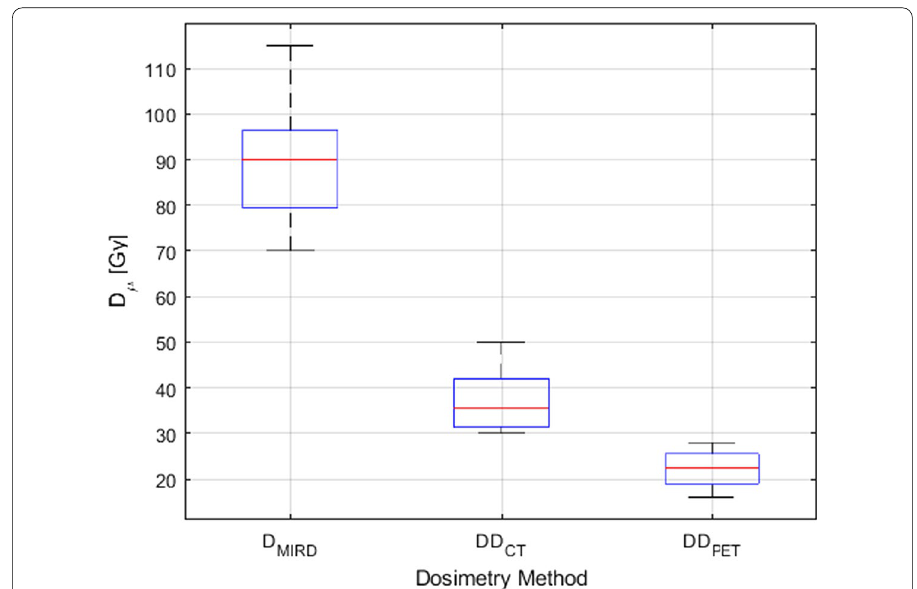
Fig. 12 Box-and-whisker plot for the mean dose D µ across all rabbits extracted from the CT-based dose distribution DD CT , the PET-based dose distribution DD PET , and DD MRD . The red line represents the median value, the blue box contains data between the 25th and 75th percentiles, and the black whiskers extend to the most extreme data points